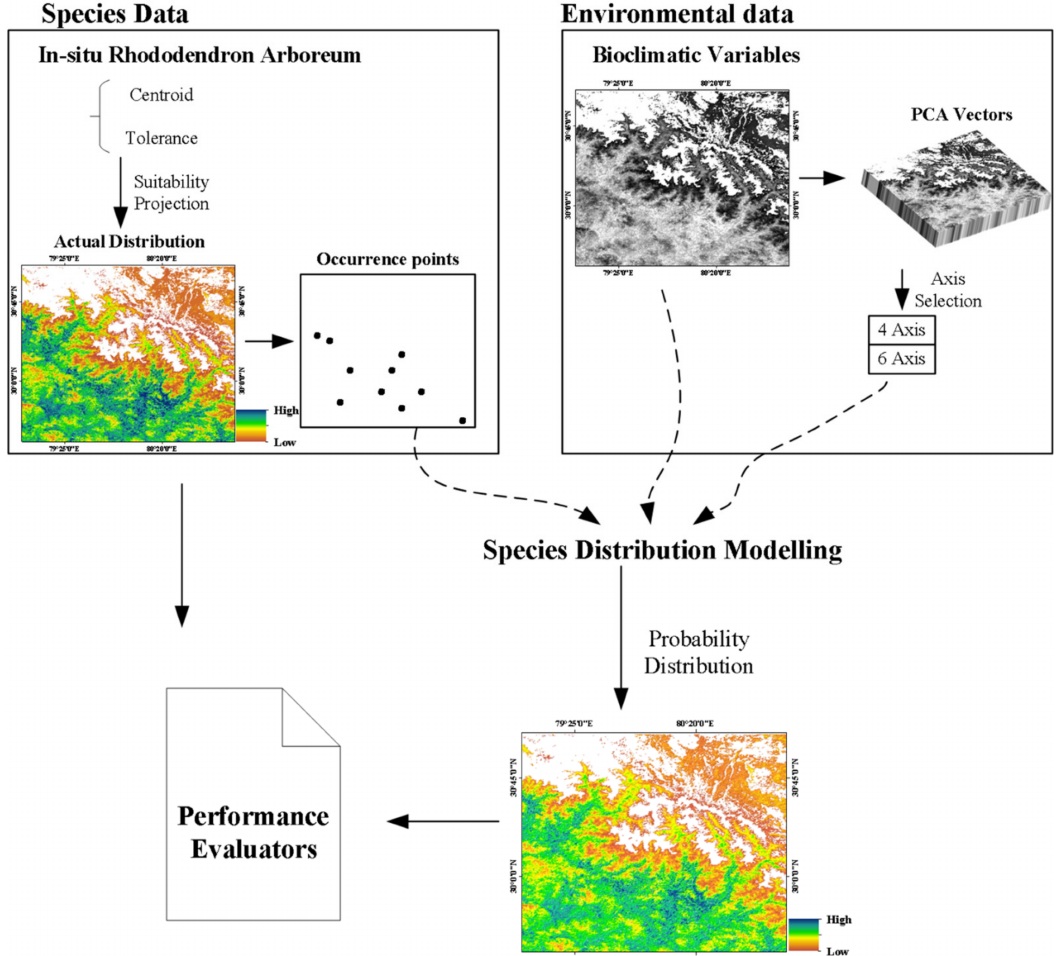
Figure 3. Flow diagram of the conventional approaches for species distribution